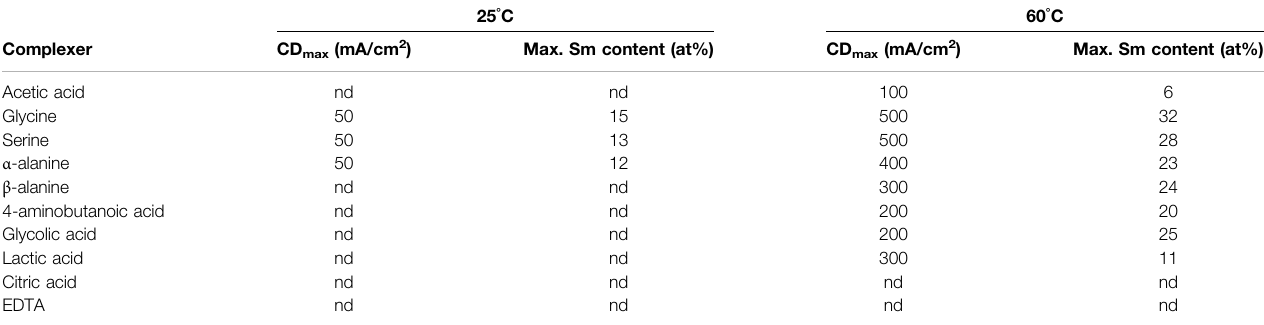
nd, non metallic deposit.